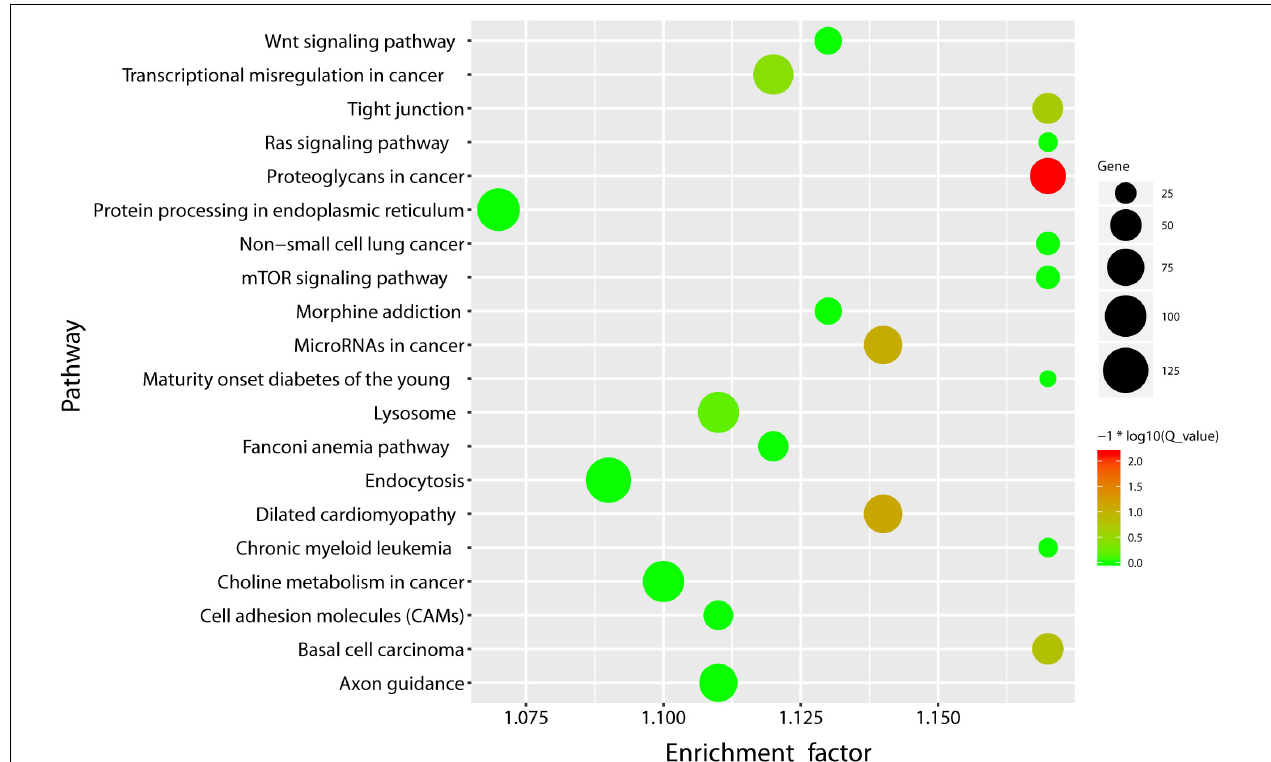
FIGURE 3 | KEGG pathway enrichment bubble plot of the differentially expressed miRNAs. X -axis label represents rich factor (rich factor = amount of differentially expressed genes enriched in the pathway/amount of all genes in the background gene set) and Y -axis label represents pathway. The size and color of the bubble represent the amount of differentially expressed genes enriched in the pathway and the enrichment significance ( Q _ value is the P value corrected after multiple hypothesis testing),